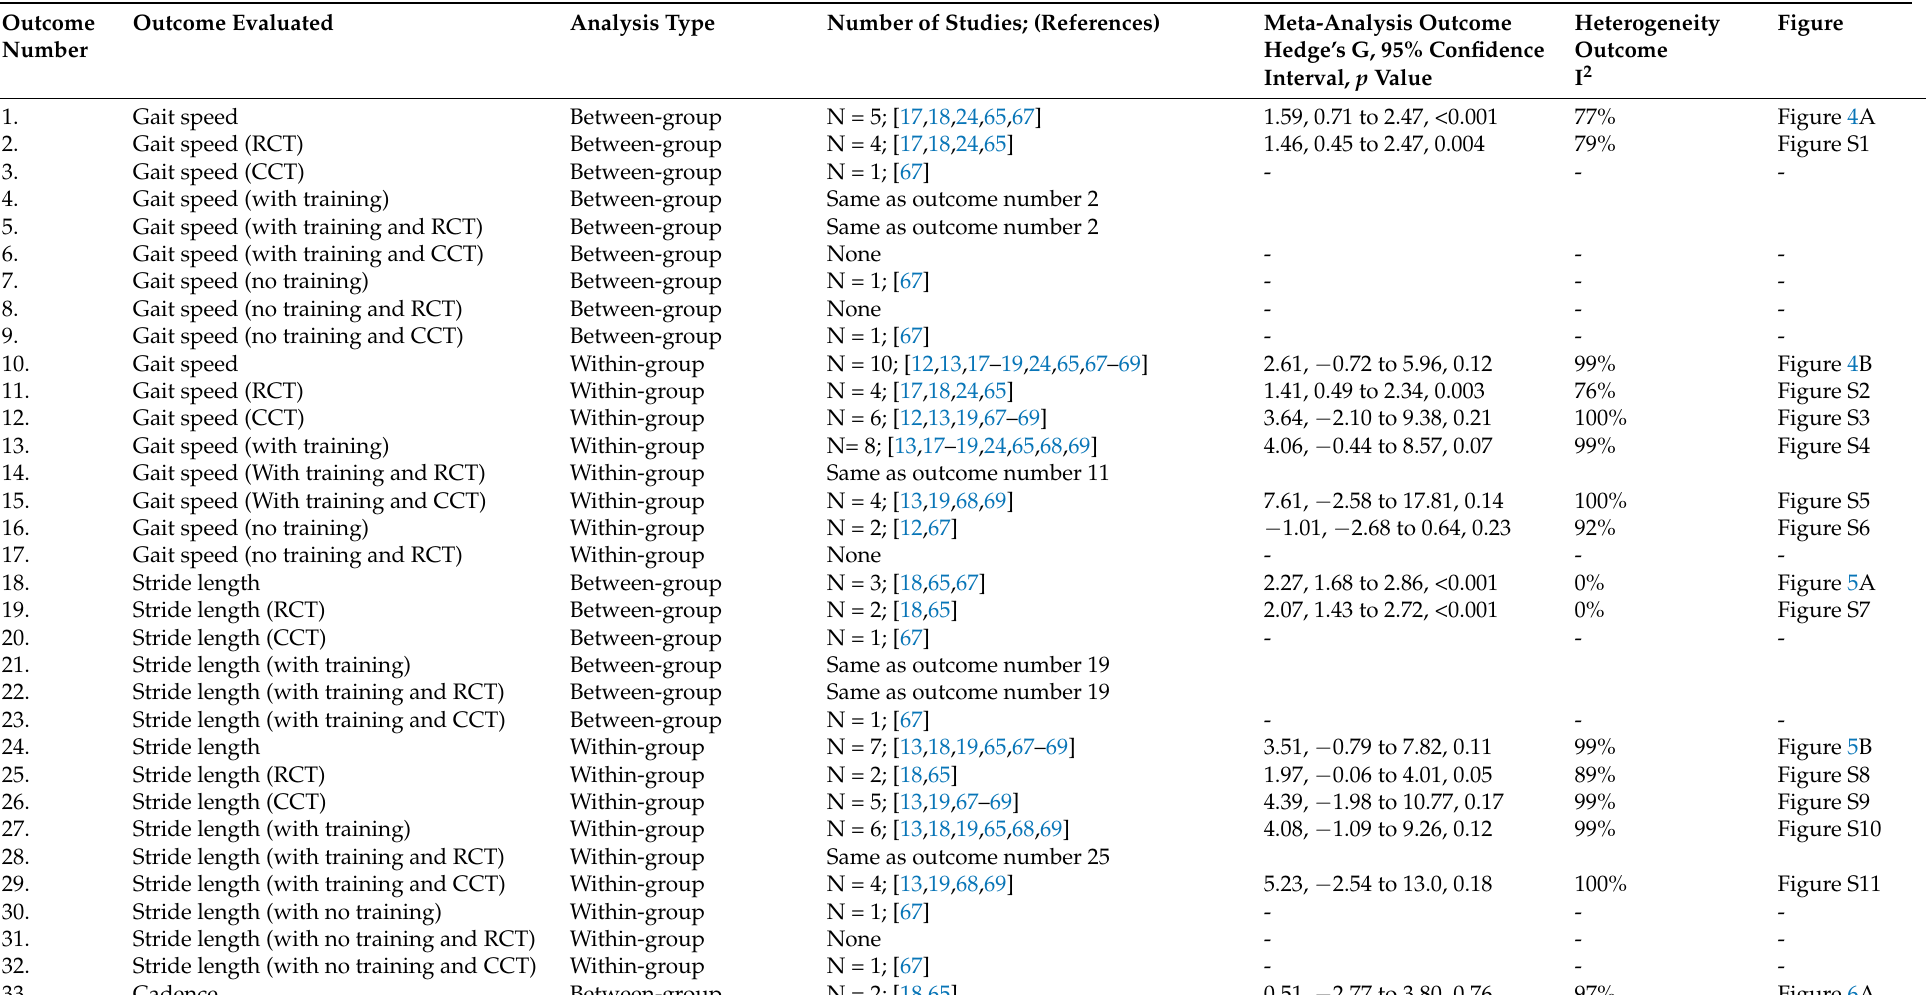
Table 3. Meta-analysis